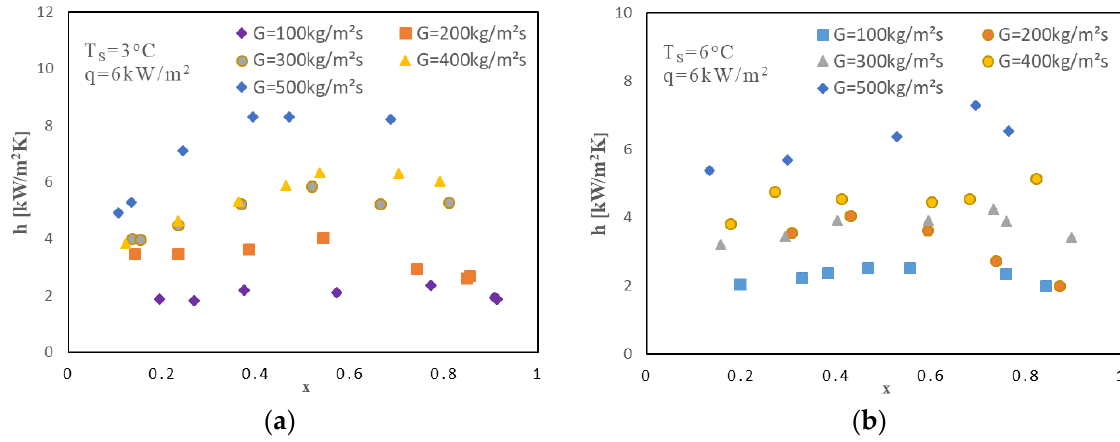
Figure 3. Effect of mass flux on heat transfer coefficient at ( a ) T sat = 3 °C and ( b ) T sat = 6